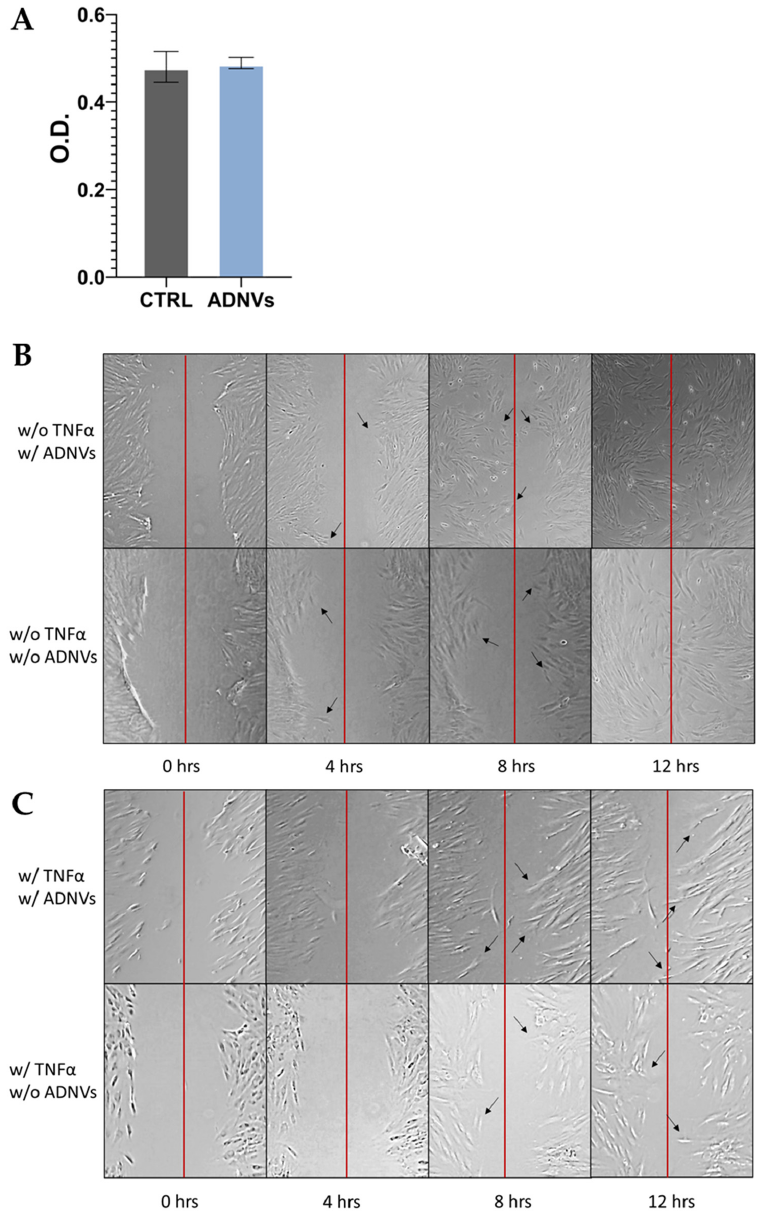
Figure 3. ( A ) MTT results for NCTC L929 cells grown in control medium (CTRL) and in ADNV-spiked medium (ADNVs); cell viability is expressed as absorbance. ( B , C ) Migration assay results are displayed as images taken in time, from 0 to 12 h (hours); the red line indicates the scratch’s middle, while black arrows point towards cells that have significantly moved since the previous image was taken.